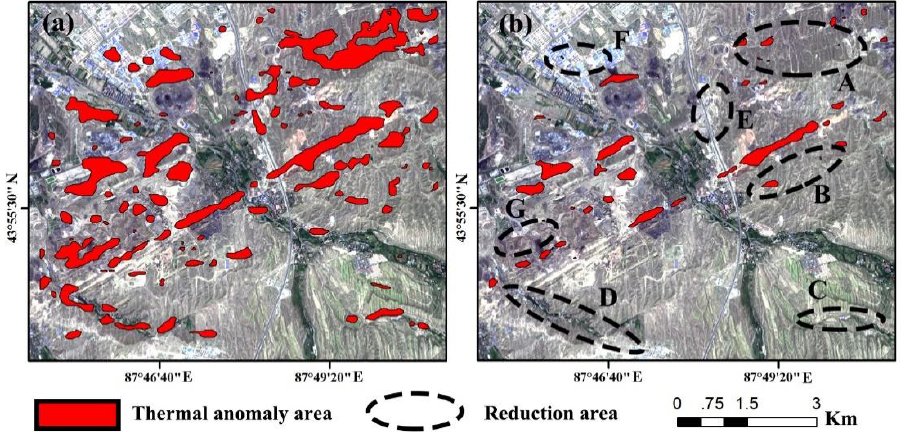
Figure 7. Thermal anomaly extraction results: ( a ) Extraction result based on the fixed threshold method [34]; ( b ) Extraction result based on the self-adaptive gradient-based thresholding method (SAGBT).